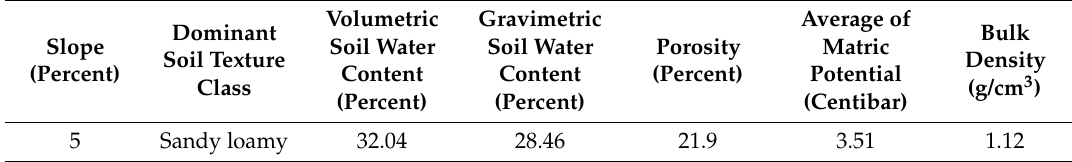
Table 1. Soil and topographic characteristics influencing on the soil infiltrability.